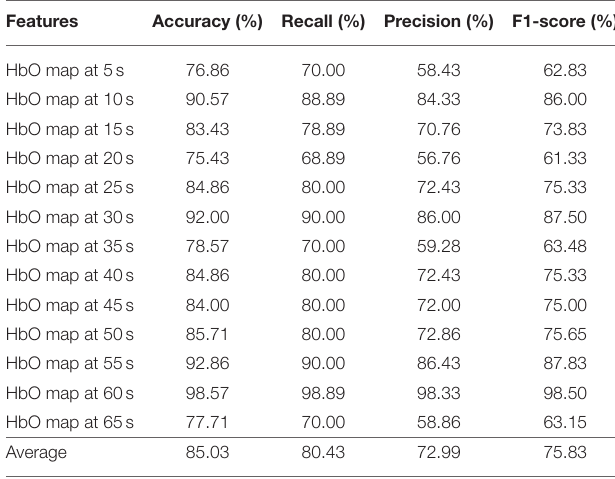
TABLE 3 | Convolutional neural network results of the temporal features among three mental tasks (i.e., N -back task, Stroop task, and verbal fluency task). Task